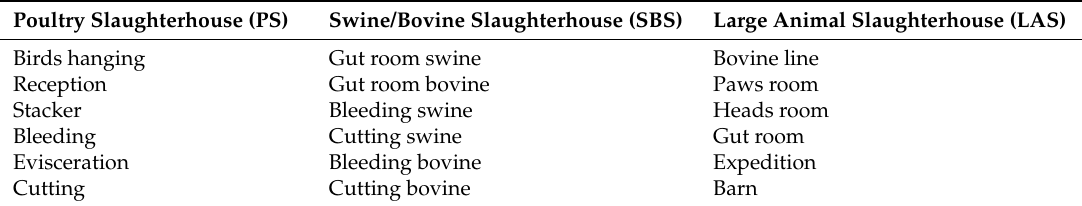
Table 1. Sampling sites selected from each